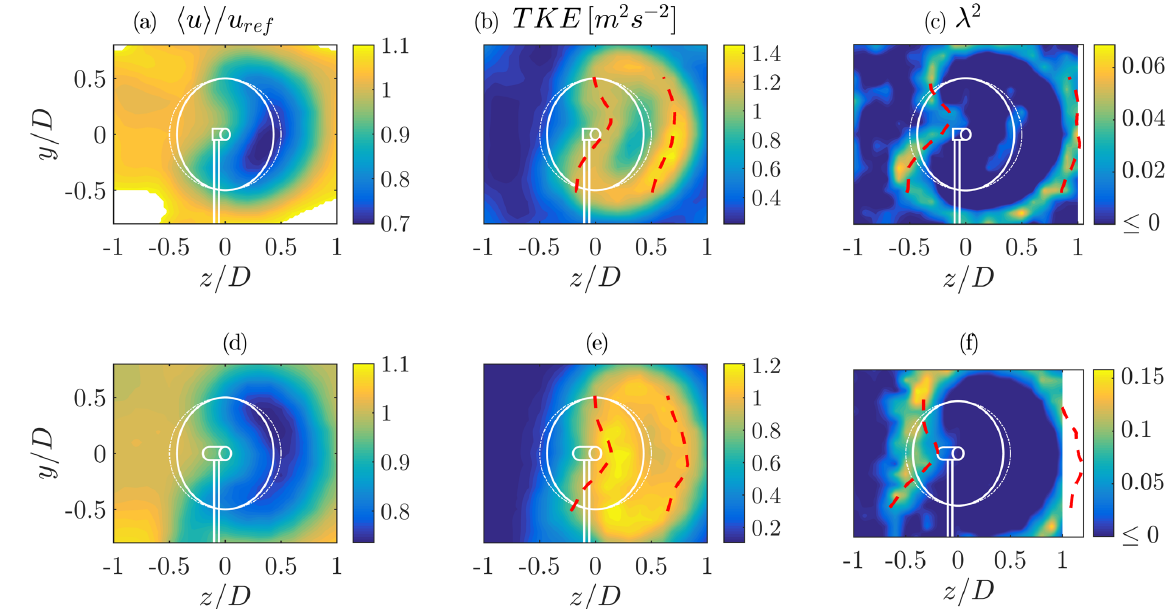
Figure 14. (cid:104) u (cid:105) /u ref (a, d) , TKE (b, e) and λ 2 (c, f) for γ = − 30 ◦ behind the NTNU turbine (a–c) and the ForWind turbine (d–f) . The timescale for λ 2 corresponds to the length scale of the rotor diameter. The red marks show the approximation of the respective parameter’s radial extension based on µ ± 1 σ u (TKE, b, e ) and µ ± 2 σ u ( λ 2 , a, d ) as described in Sect.